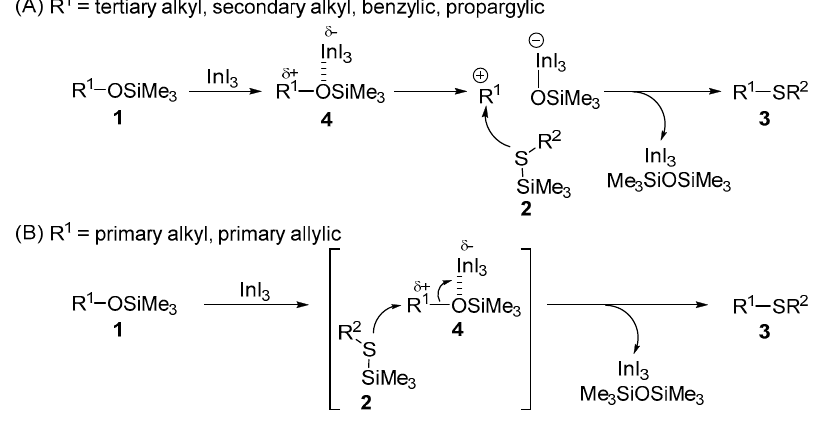
Scheme 5. Plausible reaction